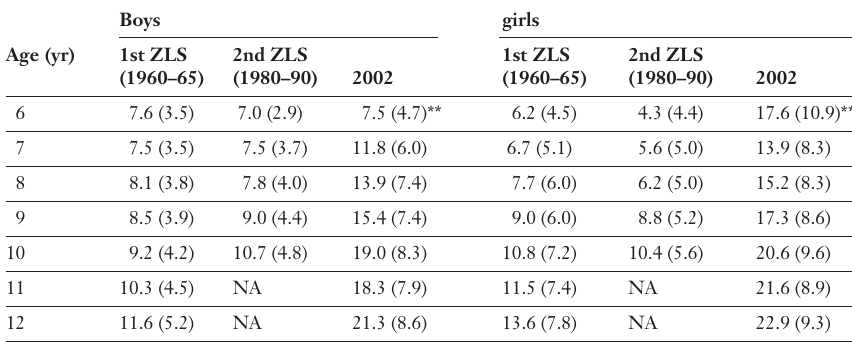
* As percentages (SE) ** Using the CDC BMI reference criteria [13].